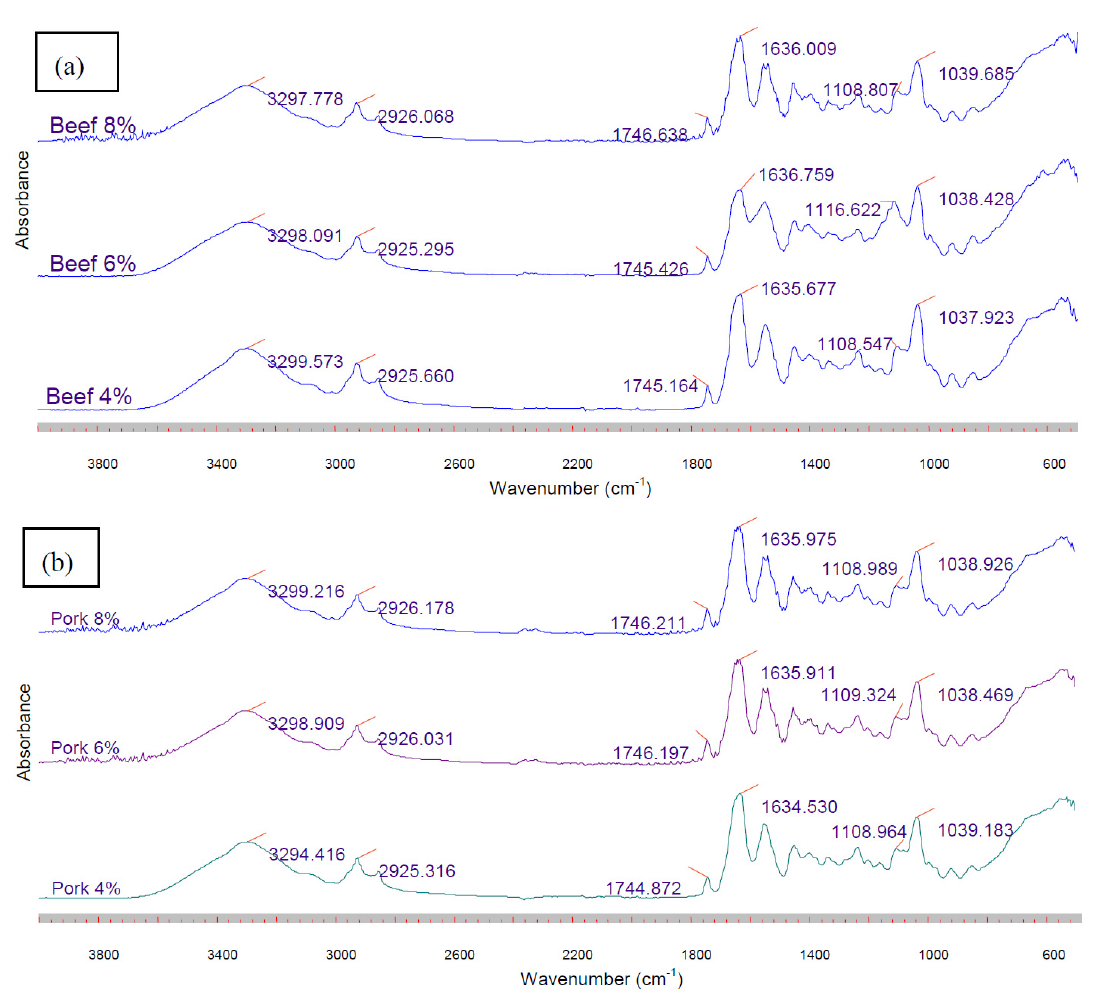
Figure 6. FTIR spectra of composite films derived from ( a ) beef, ( b ) pork and ( c ) fish sources with different concentration in the range of 4000–500 cm − 1